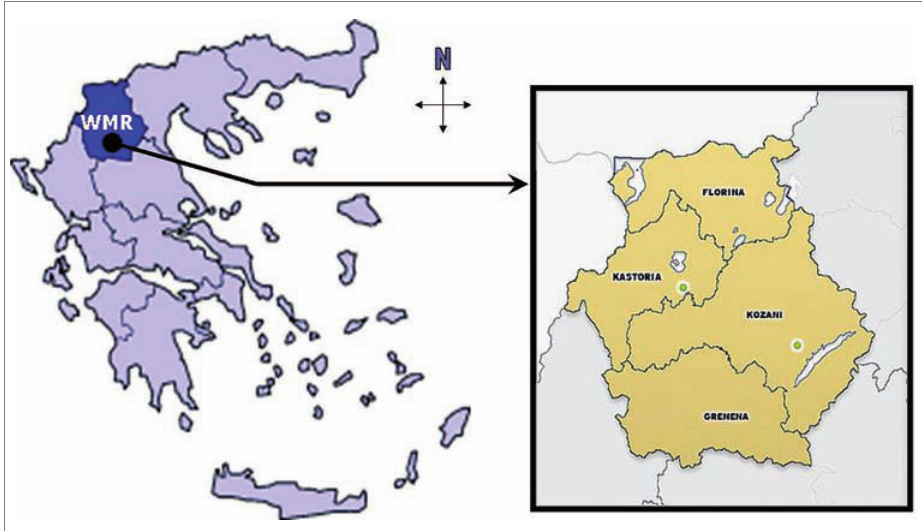
Fig. 1. Western Macedonian